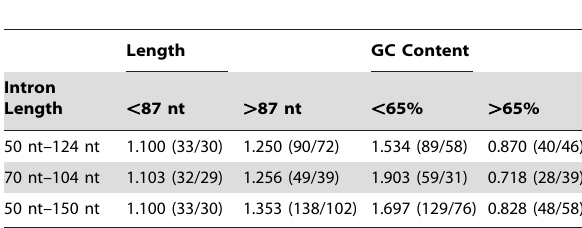
Table 2. RDI (DAF , 0.1) in different intron size intervals of the three populations.